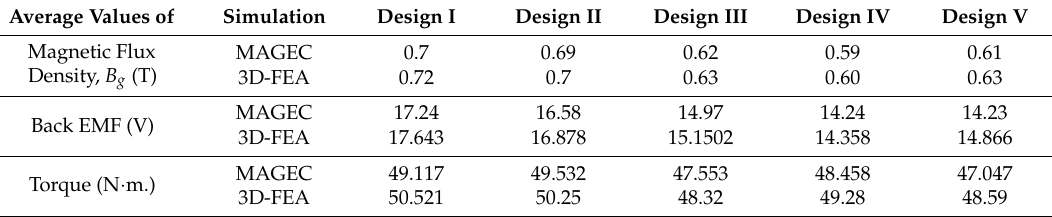
Table 5. The average values of parameters by means of the MAGEC and 3D-FEA.